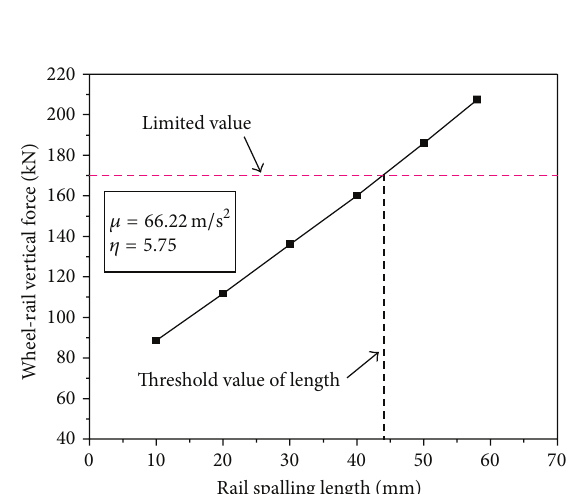
Figure 17: Influence of spalling length on the wheel-rail vertical